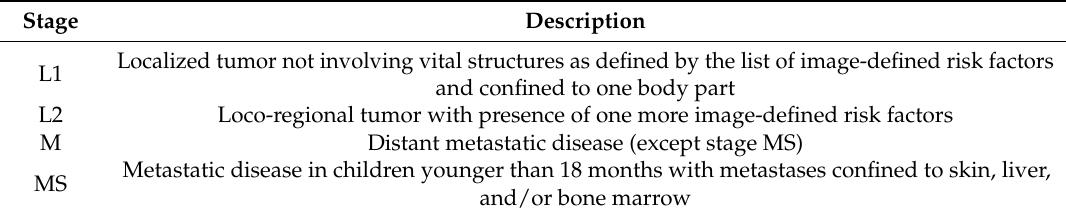
Table 1. International neuroblastoma risk group (INRG) stages